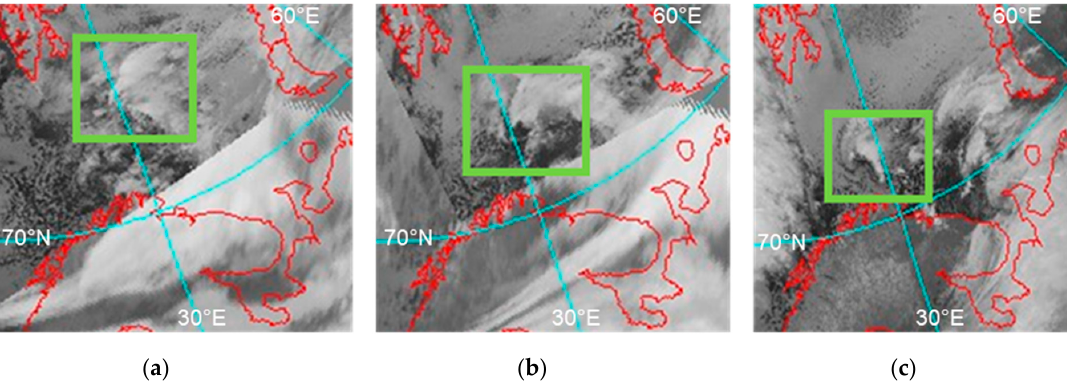
Figure 3. Satellite images of the polar low observed on 26–27 November 2019: ( a ) 04:00 UTC 26 November 2019; ( b ) 15:00 UTC 26 November 2019; ( c ) 00:00 UTC 27.11.2019. Images available from the Antarctic Meteorological Research Center (AMRC).